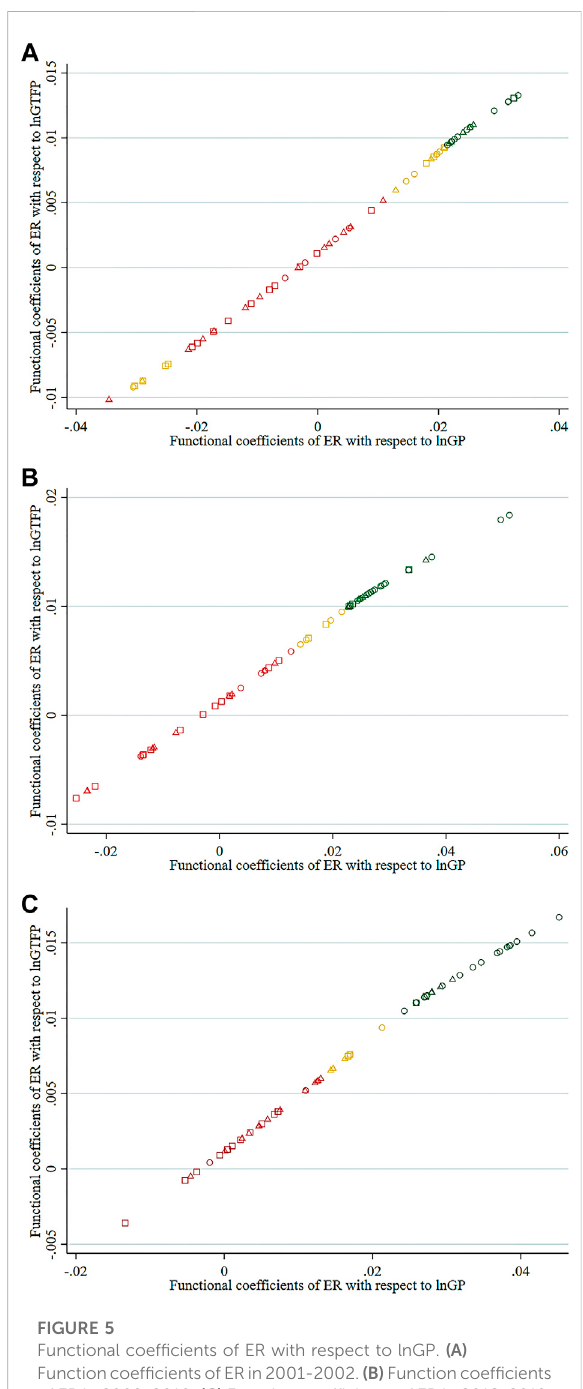
FIGURE 5 Functional coef fi cients of ER with respect to lnGP. (A) Functioncoef fi cientsofERin2001-2002. (B) Functioncoef fi cients of ER in 2009-2010. (C) Function coef fi cients of ER in 2018-2019. Note: Squares indicate when real PGDP is low; triangles indicate when actual PGDP is moderate; circles indicate when actual PGDP is high. Red indicates that the effect of ER on lnGTFP andlnGPisnotsigni fi cant;yellowindicatesthatERhasasigni fi cant effect on lnGTFP; blue indicates that ER has a signi fi cant effect on lnGP; green indicates that ER has a signi fi cant effect on both lnGTFP and